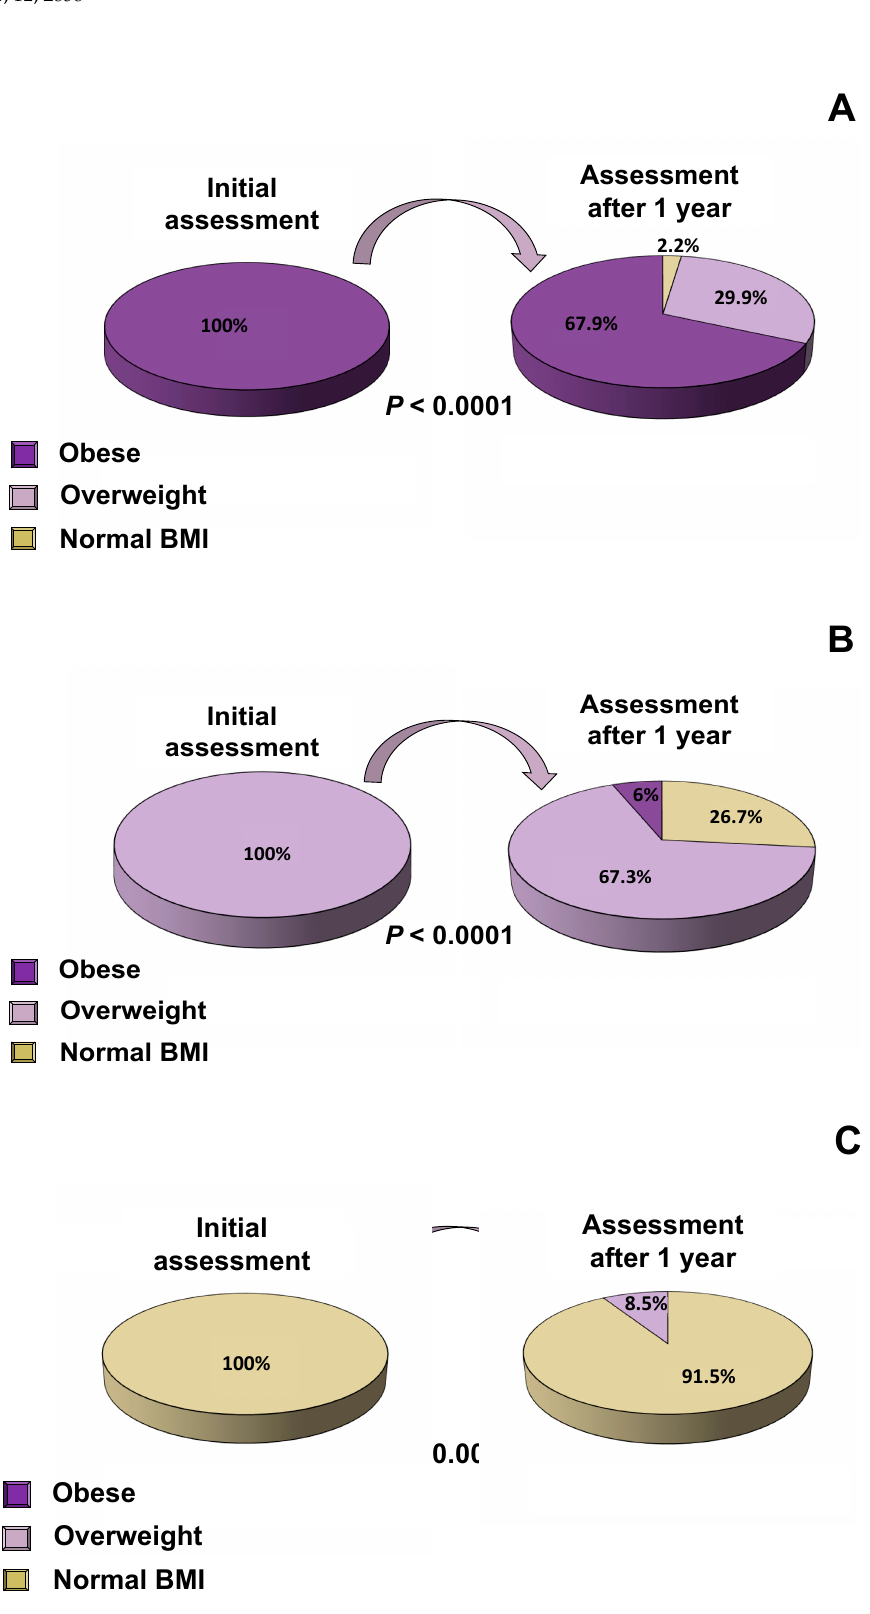
Figure 3. Alteration of BMI after 1 year of intervention: ( A ) in obese children and adolescents, ( B ) in overweight children and adolescents, ( C ) in normal BMI children and adolescents.